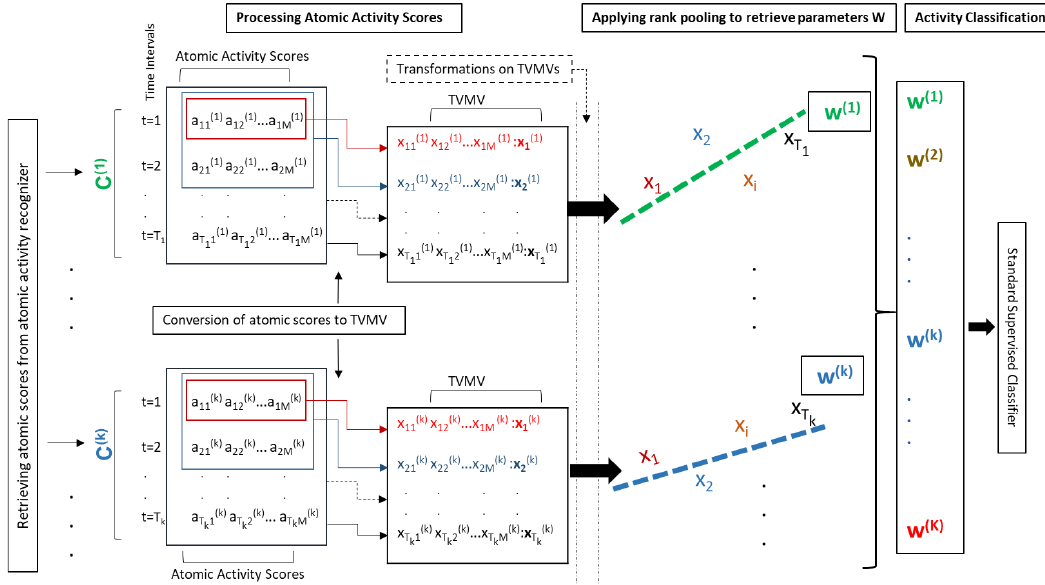
Figure 3. An overview of our composite activity recognition using rank pooling. The figure shows two examples C ( 1 ) and C ( k ) of a composite activity. Our atomic activity recognizer computes atomic scores in regular time intervals ( t = 0 → T k ) during the execution of each example of the composite activity. These atomic scores are converted to Time Varying Mean Vectors (TVMVs) (denoted by x t ). After applying non-linear transformations, we implement rank pooling on x parameters w ( k ) of a ranking function Ψ ( k ) . These parameters are used as a feature vector to represent an instance of C ( k ) . Such feature vectors are generated for all instances in the training dataset. We use a Support Vector Machine (SVM) classifier to classify the composite